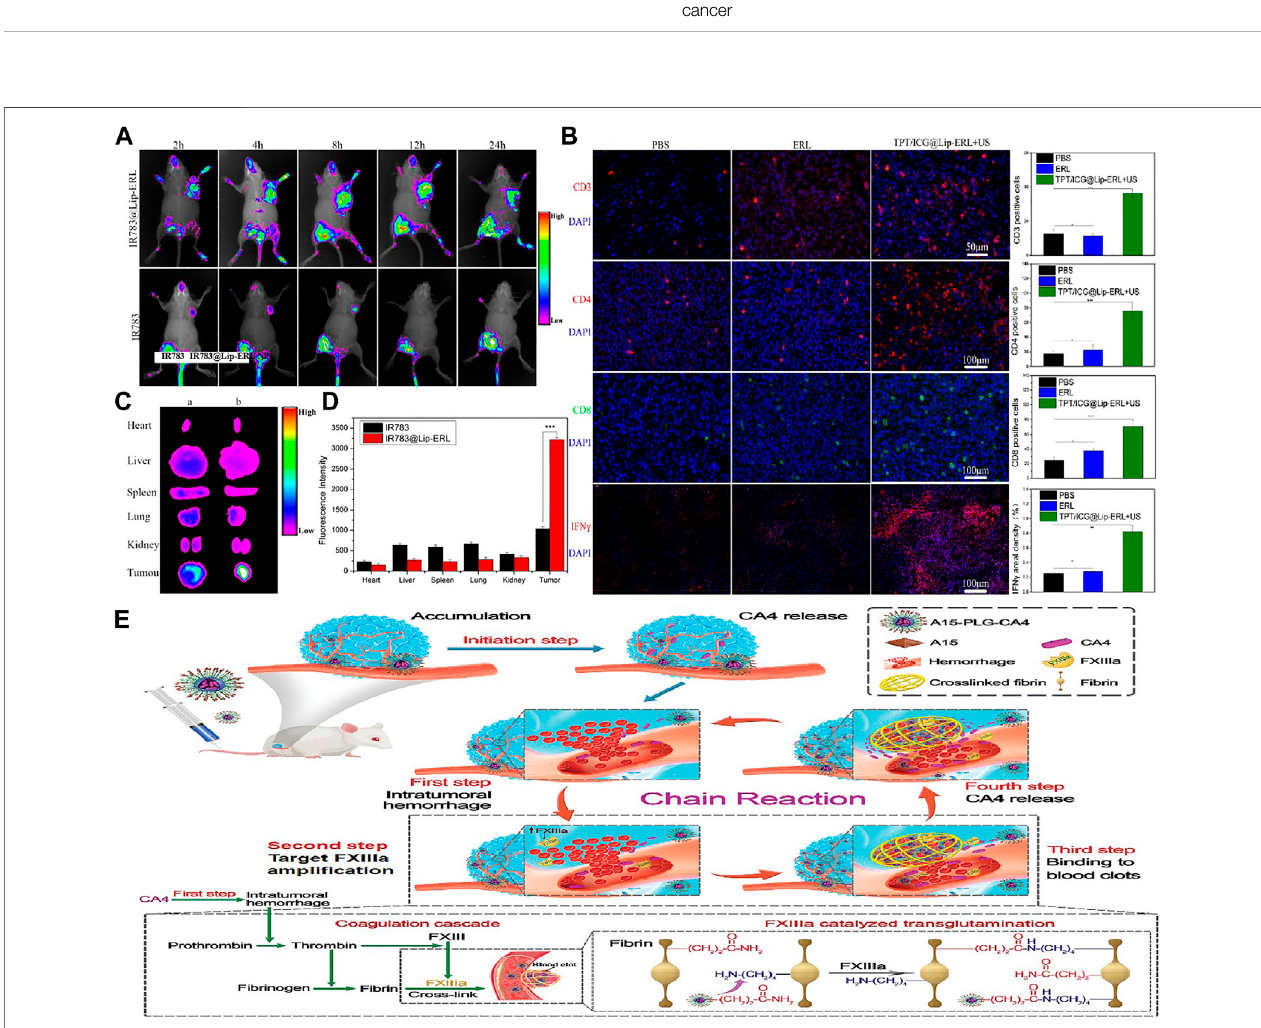
FIGURE 3 | (A) Semiquantitative mean fl uorescence intensity results of organs and tumours. Data are expressed as mean ± SD ( n = 3). (B) In vivo images of 4T1 tumour-bearingmiceadministratedwithfreeDiRorCTP/CDDP/DiRatdifferenttimes. (C) Exvivo imagesoforgansandtumoursexcisedfromtumour-bearingnudemice at 12 h after intravenous injection of different drugs. (D) Semiquantitative mean fl uorescence intensity results of organs and tumours. Data are expressed as mean ± SD ( n = 3). (E) Schematic illustration of the self-amplifying tumour-homing nanotherapeutic platform, A15-PLG-CA4, characterized by chain reactions. (A,B,C,D) is reprinted with permission from reference (Chen et al., 2021). (E) is reprinted with permission from reference (Wang et al.,